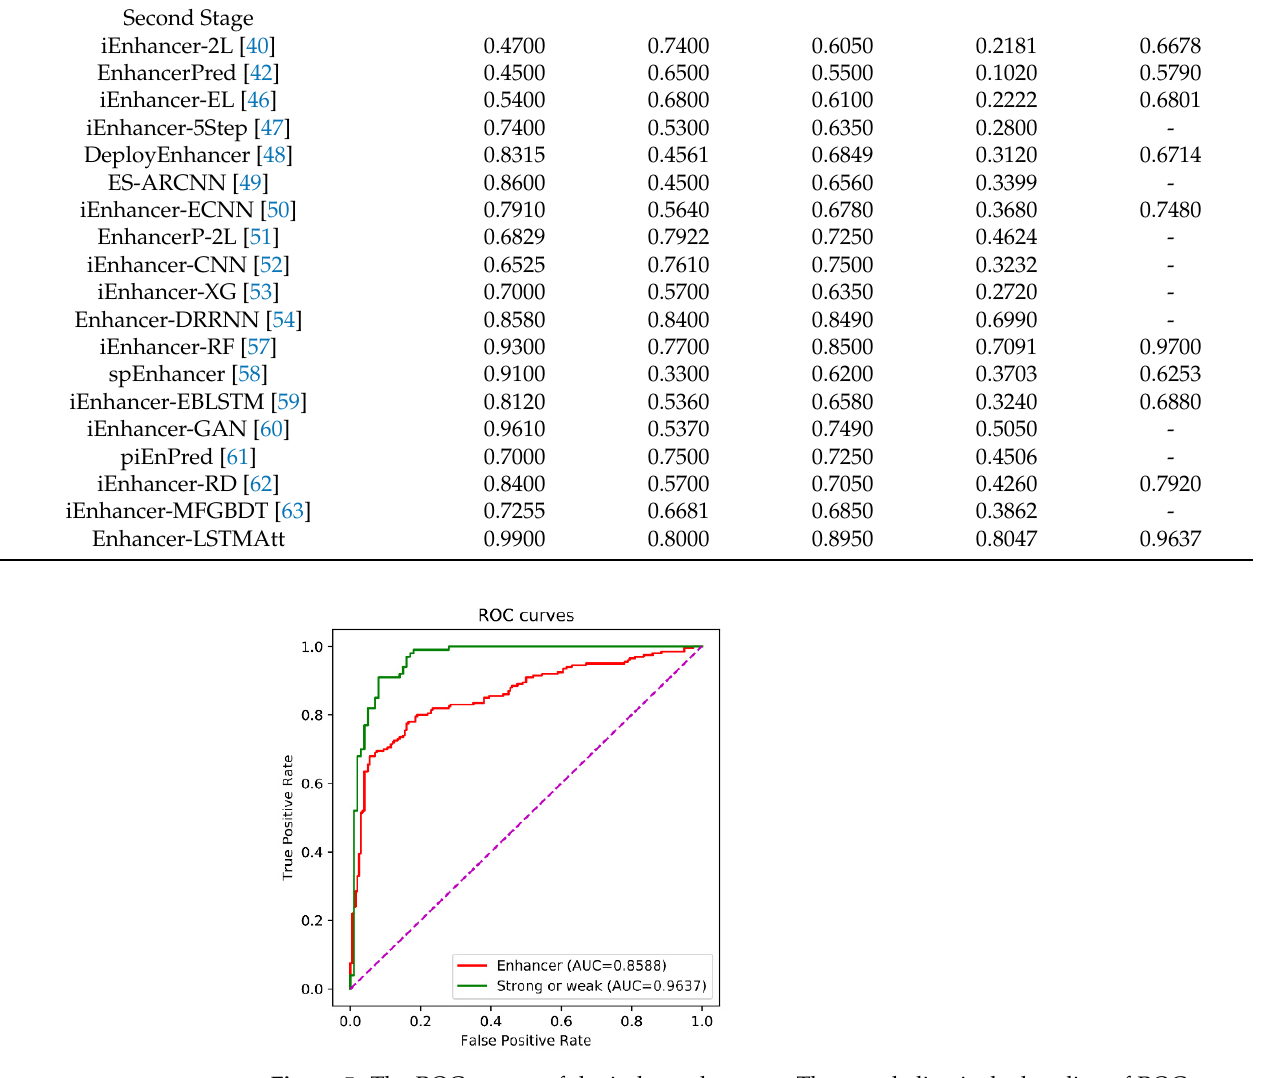
Figure 5. The ROC curves of the independent test. The purple line is the baseline of ROC curve, named random guess line.